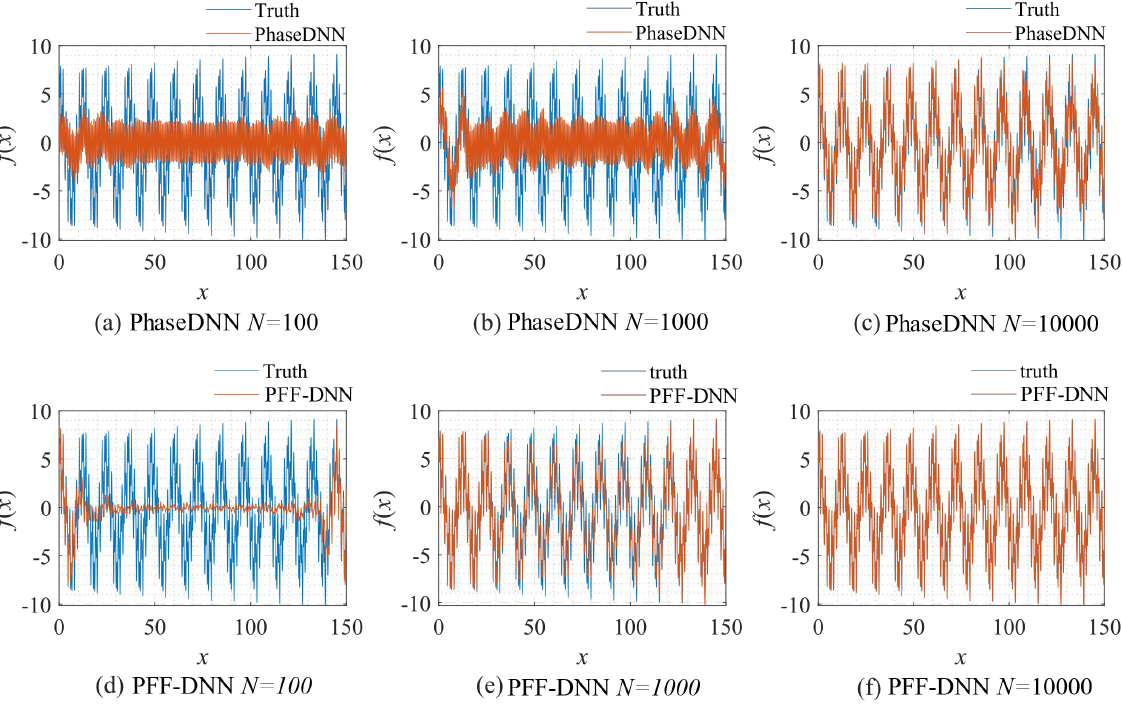
Figure 13. The influence of N on the algorithm performance. Fitting results of the PhaseDNN method when Δ ω = 11: ( a ) N = 100; ( b ) N = 1000; and ( c ) N = 10,000. Fitting results of the PFF-DNN method when Δ ω C= 11: ( d ) N = 100; ( e ) N = 1000; and ( f ) N = 10,000.